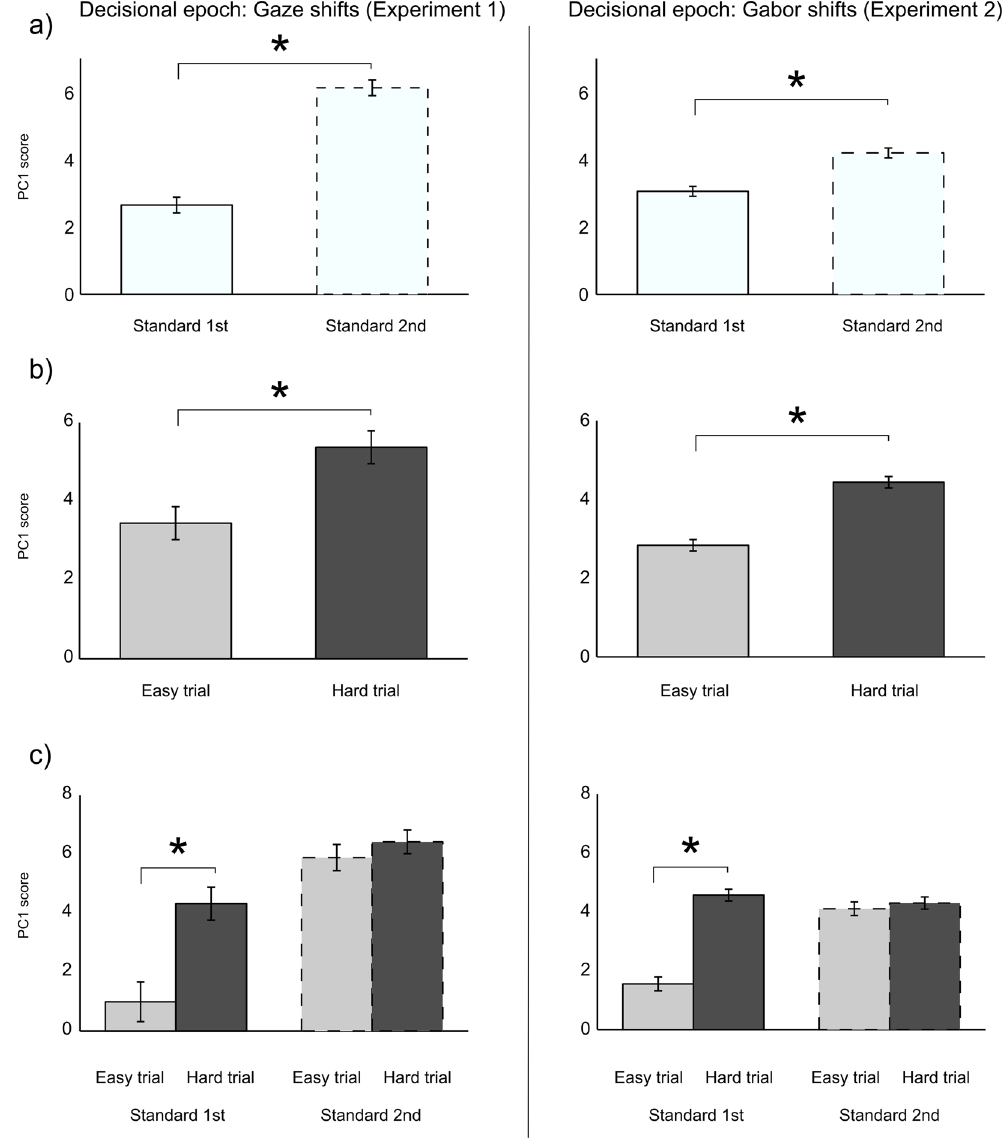
Figure 3. Decisional epoch pupil responses associated with the duration classification of Gaze shift stimuli (Experiment 1, left column) and Gabor shift stimuli (Experiment 2, right column). ( a ) Rate of pupil increase during the decisional epoch (PC1 score) as a function of stimulus order in trial: trials in which the Standard follows the Probe (Standard 2 nd ) are characterized by faster increases in pupil diameter with respect to trials in which the Standard precedes the Probe (Standard 1 st ), ( b ) PC1 score during the decisional epoch as a function of trial difficulty: hard trials (where standard and probe have same duration, thus being harder to classify) exhibit faster increases in pupil diameter with respect to easy trials (where Standard and Probe have noticeably different durations), ( c ) PC1 score during the decisional epoch as a function of trial difficulty and stimulus order: difference in pupil response between hard and easy classifications is only observed in trials in which Standard occurs 1 st (i.e. decisional epoch occurs immediately after the offset of the